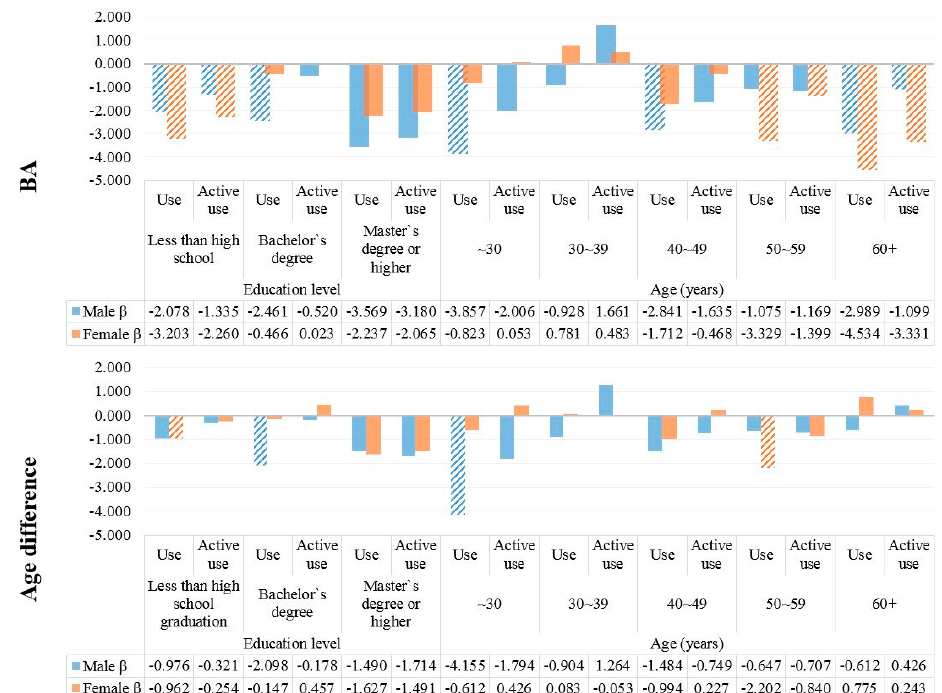
Figure 1. Subgroup linear regression analyses exploring associations between the use of nutrition facts and BA and BA–CA by age and education level. Marked plot mean statistically significant ( p < 0.05).